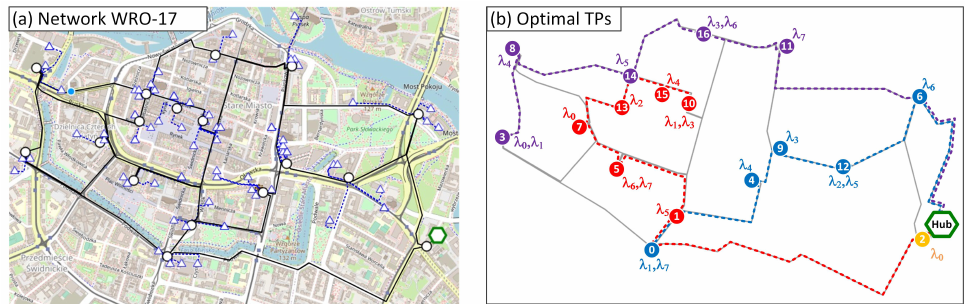
Figure 10. ( a ) WRO-17 network topology and ( b ) optimal configuration of TPs in WRO-17 assuming traffic load ρ = 1.5 and WDM capacity W =